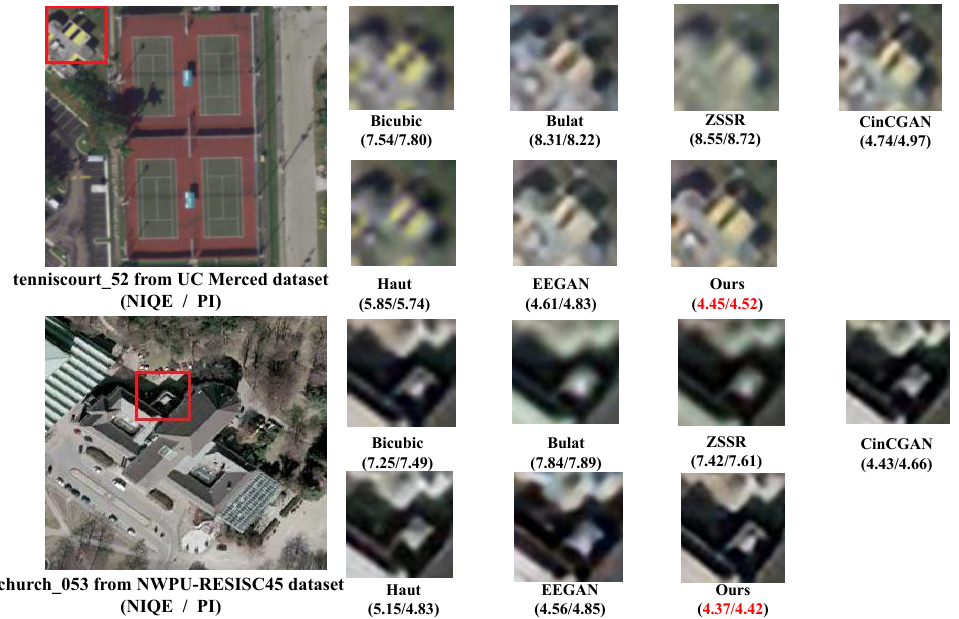
Figure 9. Visual comparison on two remote sensing datasets with the scale factor of 4 on the UC Merced dataset, see upper images, and for results on the NWPU-RESISC45 dataset see lower images. The LR inputs and SR outputs in both cases are 100 crop ROIs in the SR images for better comparison. We also compute the NIQE and PI for each ROI, for which lower values denote better quality. We can also easily observe that UVRSR wins the first place among all methods.